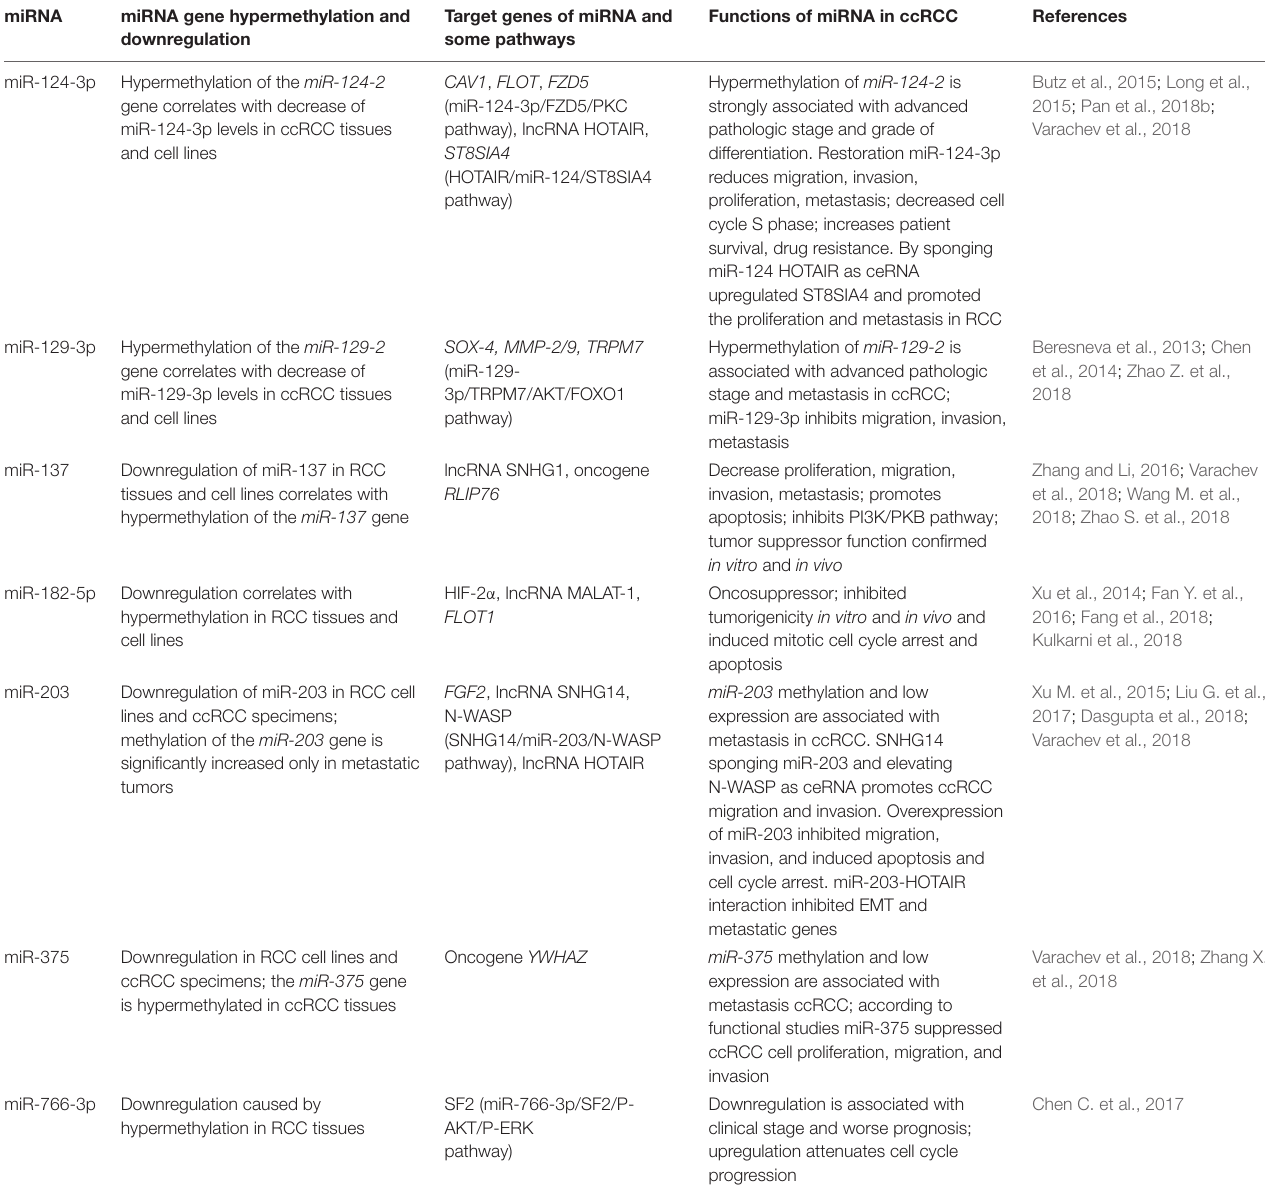
TABLE 1 | Examples of the most studied miRNAs encoded by hypermethylated genes in ccRCC, focusing on the role of aberrant methylation in miRNA deregulation, target genes, and